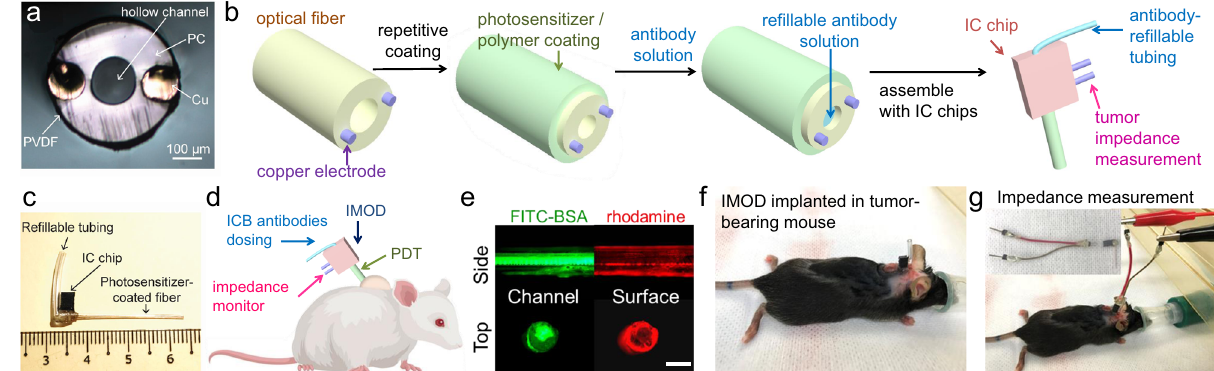
Fig. 1 Design and fabrication of an implantable miniaturize optical fi ber device (IMOD) for on-demand drug delivery and tumor impedance measurement. a The cross-section image of an uncoated optical fi ber with embedded electrodes for measuring tumor impedance. PC, polycarbonate; PVDF, polyvinylidene di fl uoride. b Procedure for coating the optical fi ber surface with hydrophobic molecules (e.g., vertepor fi n or rhodamine) and fi lling the inner channel of the fi ber with hydrophilic drugs (e.g., immune checkpoint blockade (ICB) antibodies or fl uorescein isothiocyanate – bovine serum albumin (FITC-BSA)). The obtained fi ber was assembled with an integrated-circuit (IC) chip to the IMOD device. c An image of IMOD with a re fi lling tubing and IC chip. d IMOD combines photodynamic therapy, immune checkpoint therapy, and impedance measurement, thus allowing for monitoring of treatment ef fi cacy and adjustment of the antibody dosage to generate a sustained anti-tumor immune response while minimizing systemic toxicities. e Fluorescence imaging of an optical fi ber coated with rhodamine B (red) and loaded with FITC-BSA (green). Scale bar: 500 µ m. Data are representative of three repeated experiments. f Implantation of IMOD into a subcutaneous E0771 tumor in a C57BL/6 mouse. g Connection of IMOD in ( f ) via an electrical connector to a Gamry potentiostat for impedance